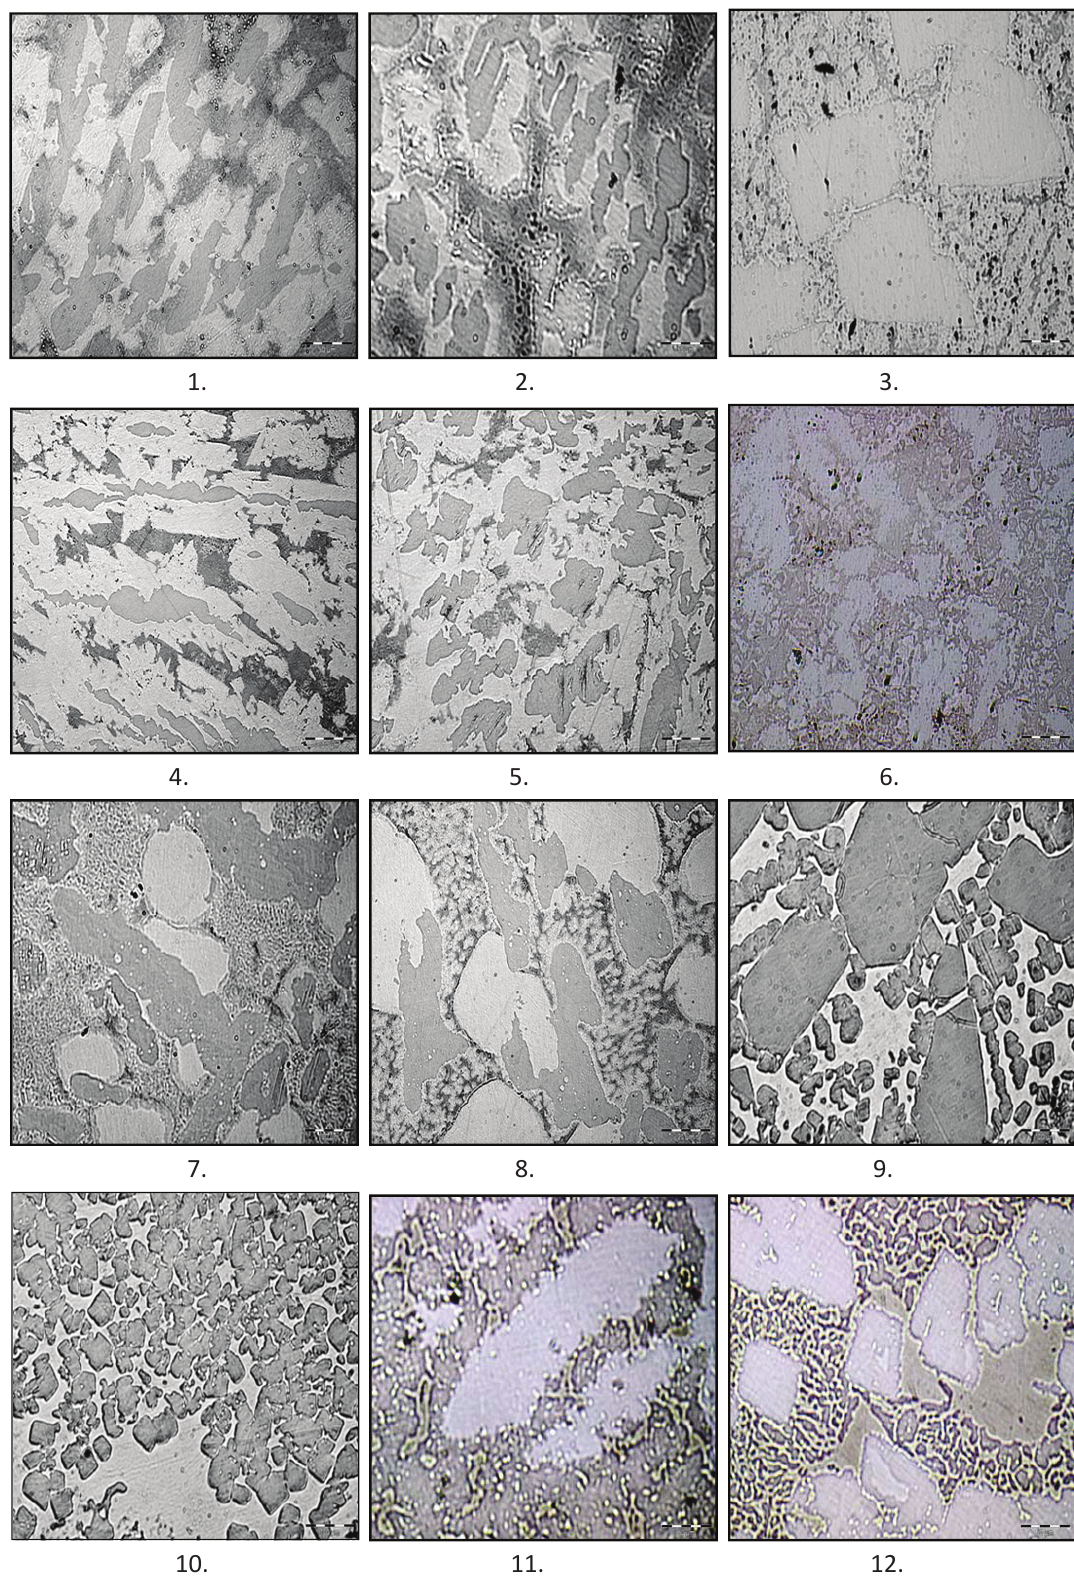
Figure 7. Microstructures of the alloys of ternary Bi-Sb-Sn